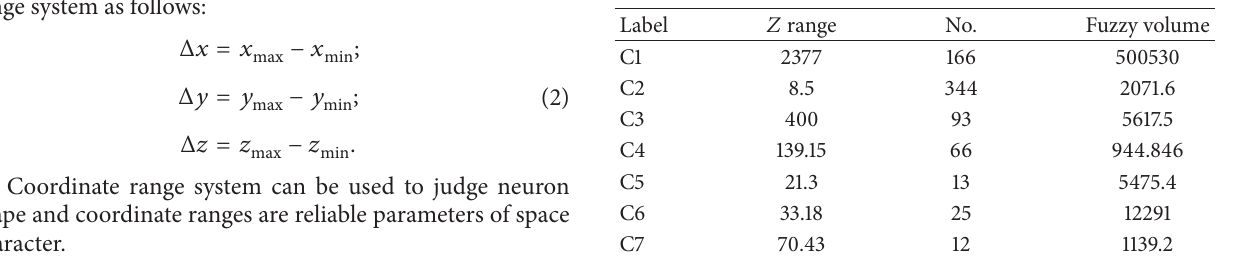
Table 4: Fuzzy volume of standard data in data set